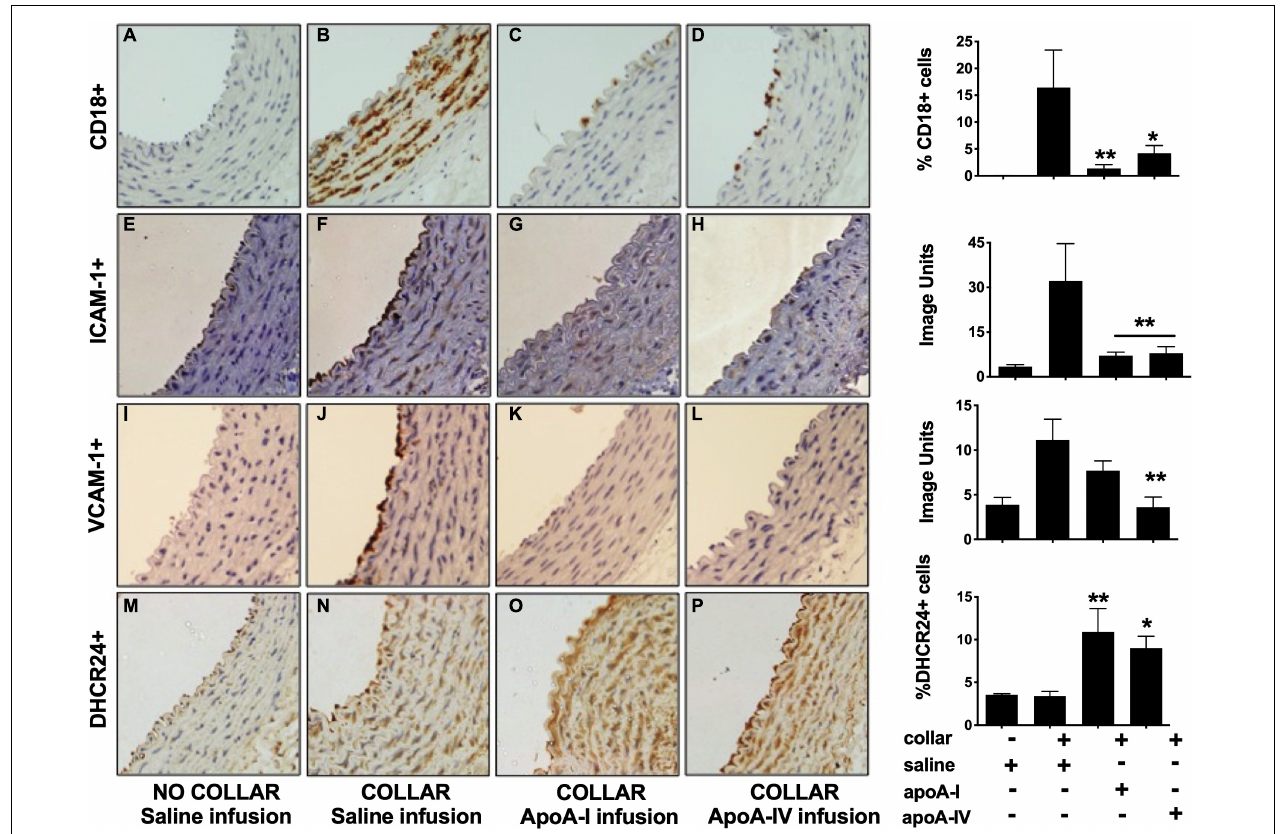
FIGURE 1 | Apolipoprotein A-IV inhibits acute vascular inflammation in NZW rabbit carotid arteries. NZW rabbits ( n = 6/group) were infused iv with saline [Panels (A,B,E,F,I,J,M,N) ], apoA-I [Panels (C,G,K,O) ; 8 mg/kg iv] or apoA-IV [Panels (D,H,L,P) ; 1 mg/kg iv] 24 h prior to inserting a non-occlusive peri-arterial collar around the left common carotid artery. The animals were euthanised 24 h post-collar insertion. Sections from the non-collared [Panels (A,E,I,M) ] and the collared carotid arteries were stained for neutrophils [CD18, Panels (B–D) ], ICAM-1 [Panels (F–H) ], VCAM-1 [Panels (J–L) ] and DHCR24 [Panels (N–P) ]. Representative immunostained images as shown. * p < 0.05, ** p <